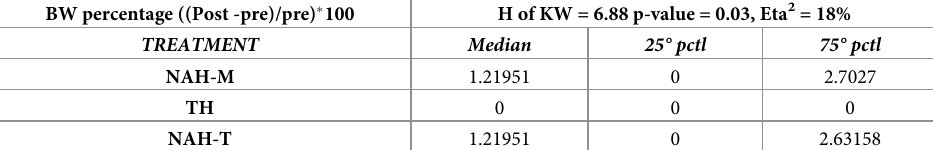
Table 2. Percentage of body weight increase after R&L stress, (H value of Kruskal Wallis = 6,88; p = 0,032, Eta 2 18%). NAH-T and NAH-M were associated with a significant increase in BW after stress with respect to TH. TH han- dled animals showed no body weight increase after R&L stress, therefore the BW percentage value was 0. BW percentage ((Post -pre)/pre) � 100 H of KW = 6.88 p-value = 0.03, Eta 2 =